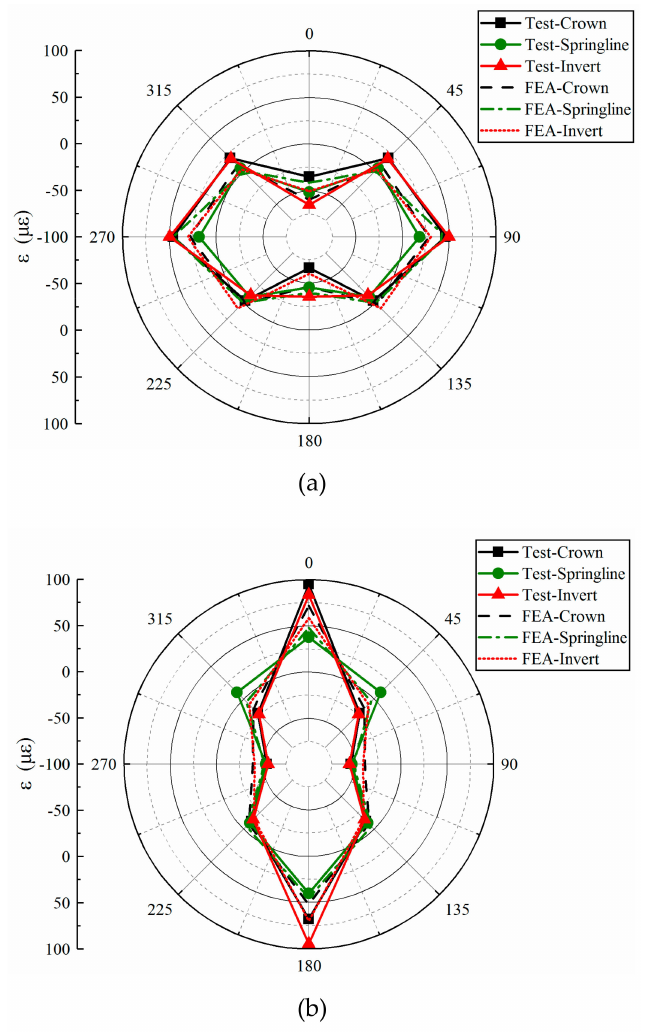
Figure 25. Circumferential strain curves of the pipes containing cracks at di ff erent positions: ( a ) outer wall and ( b ) inner